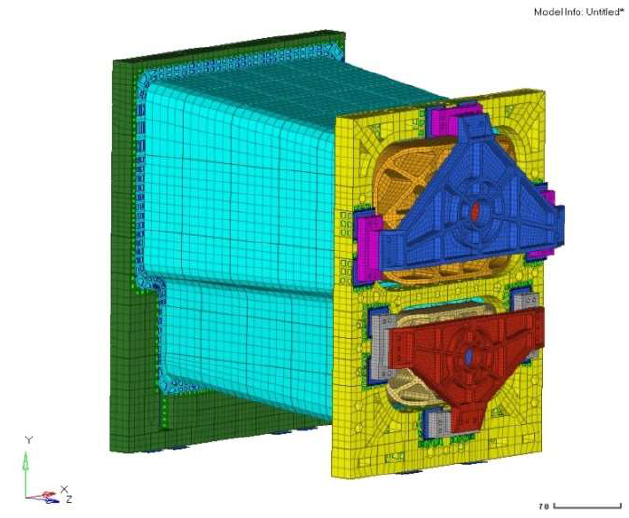
Figure 8. Finite element model of the off-axis remote sensing camera.